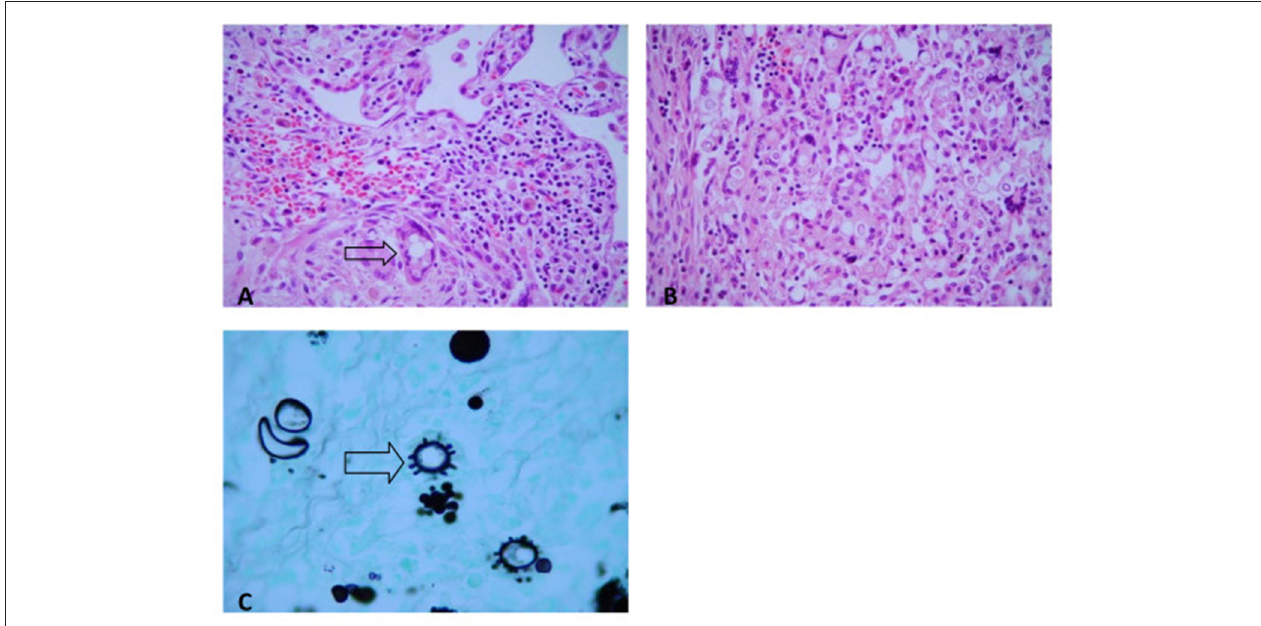
FIGURE 2 | Paracoccidioidomycosis. (A) Lung. Epithelioid granuloma with multinucleated giant cells and yeast P. brasiliensis forms (H&E, × 200). (B) Colon. Epithelioid granuloma with multinucleated giant cells, and yeast P. brasiliensis forms (H&E, × 200). (C) Typical multiple-budding cell of P. brasiliensis seen in a GMS-stained (GMS, ×